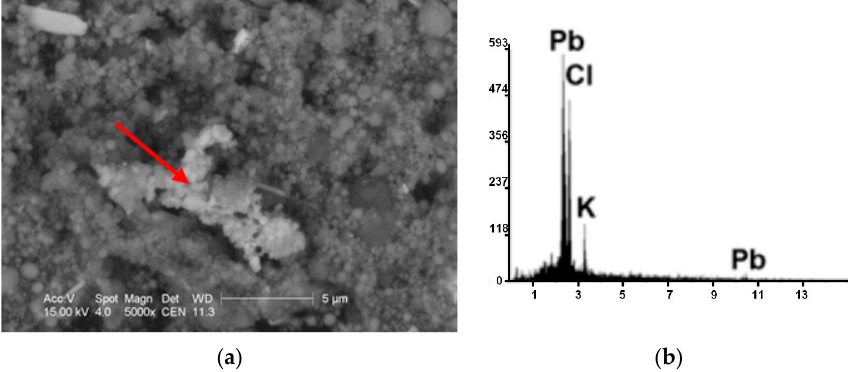
Figure 12. Dust particles from the sinter plant (sample No. 9): ( a ) SEM image; red arrow indicates a challacolloite KPb 2 Cl 5 aggregate; ( b ) the EDS spectrum